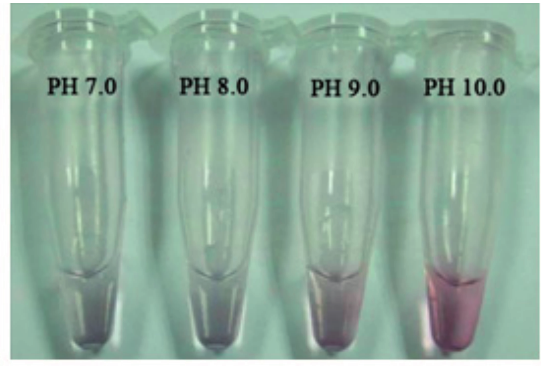
Figure 3. Different pH for the conjugation between colloidal gold and